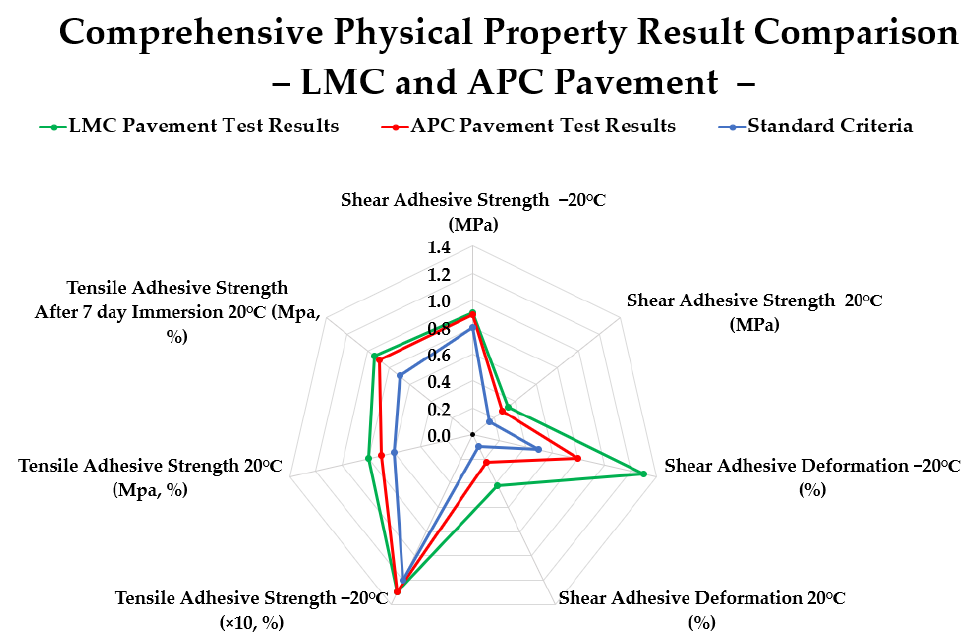
Figure 8. Comparison of the performance of the waterproofing layer in the APC and LMC pavements.